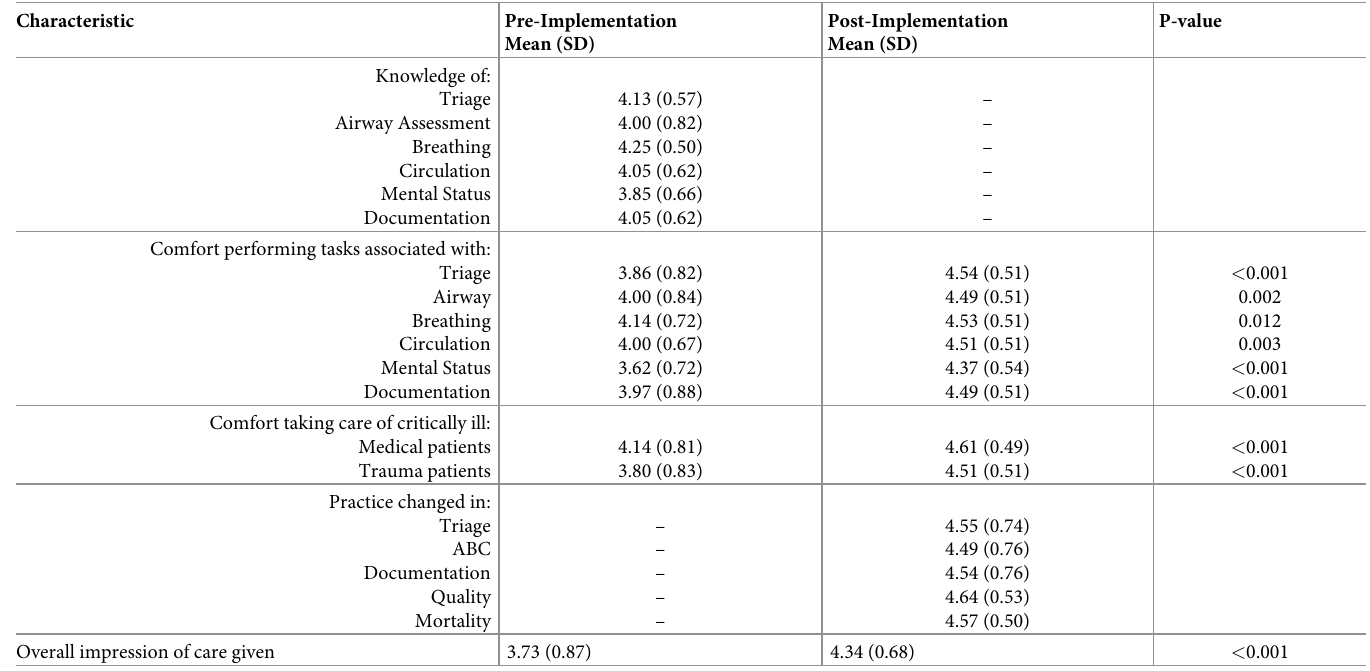
Overall impression of care